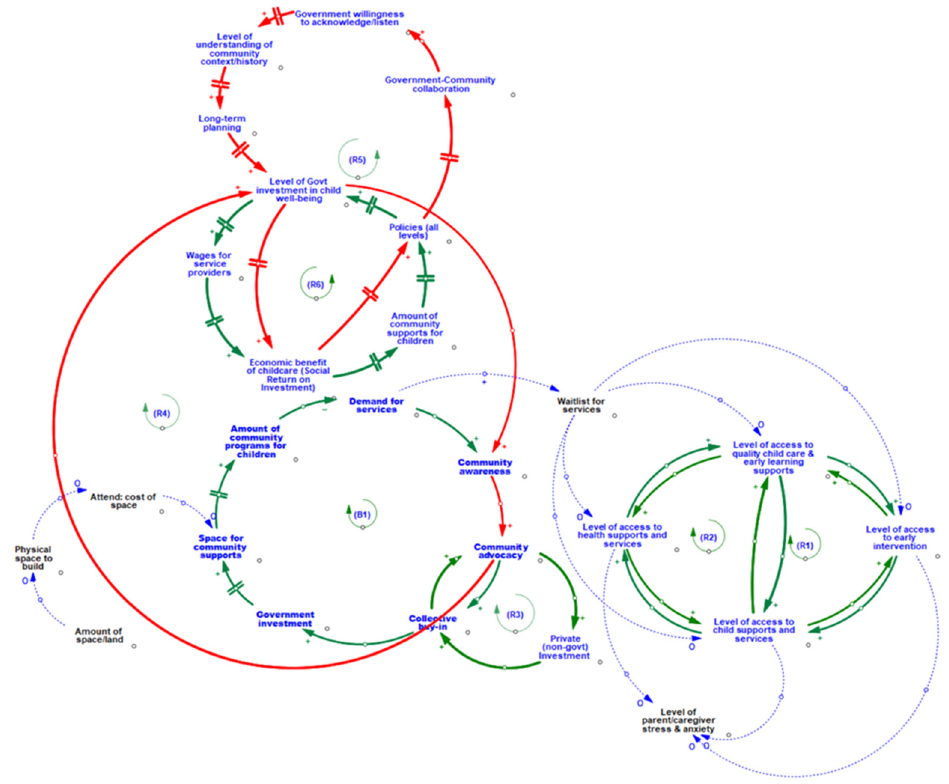
Figure 4. System of community environment influences on children’s social and emotional well- being in Kamloops, BC. in Kamloops,